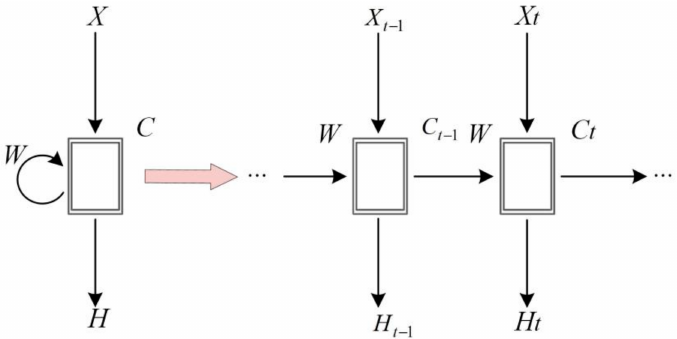
Figure 1. Structural schematic diagram of a recurrent neural network